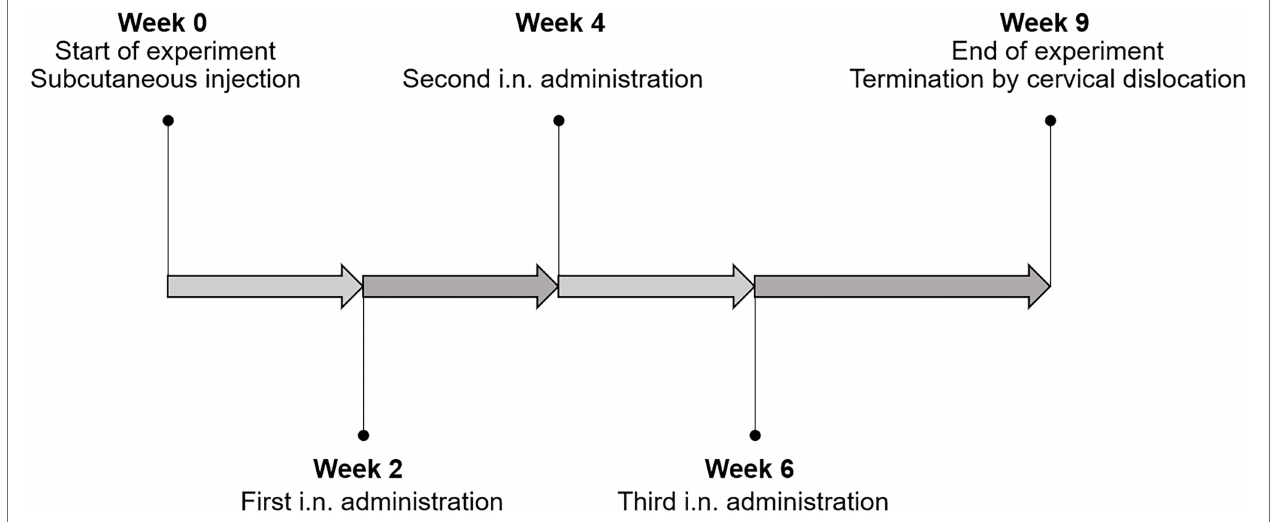
FIGURE 2 | The immunization schedule. All mice were primed with a subcutaneous injection at the start of the experiment (week 0), followed by three intranasal administrations at week 2, 4, and 6. The mice were terminated 3 weeks after the last immunization (week